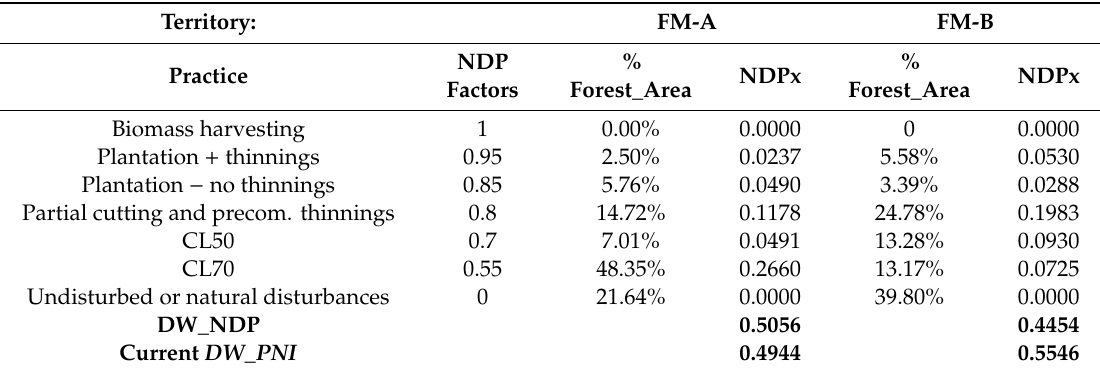
Table A3. Naturalness degradation potential for dead wood (DW_NDP) by silvicultural treatment in Montmorency